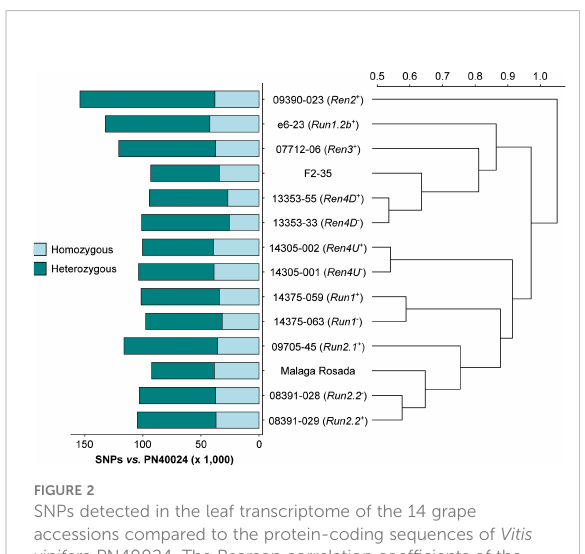
FIGURE 2 SNPs detected in the leaf transcriptome of the 14 grape accessions compared to the protein-coding sequences of Vitis vinifera PN40024. The Pearson correlation coef fi cients of the pairwise SNP comparison were converted into distance coef fi cients to de fi ne the height of the dendrogram